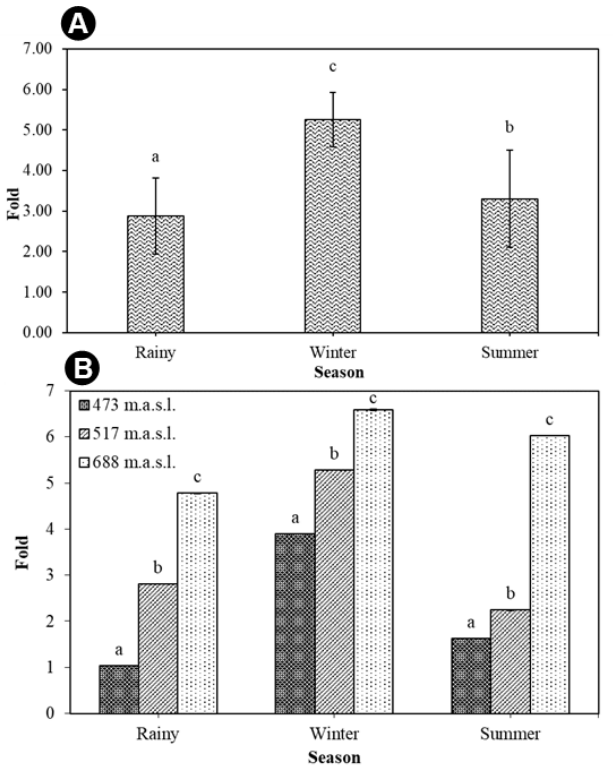
Figure 12 ( A ) Mean of comparisons of total carotenoid content and total chlorophyll ( a and b ) ratios and ( B ) total carotenoid content and total chlorophyll ( a and b ) ratios in each sampling point in each season of T. rigidula collected from electricity posts. Data are the mean values of three replications, and the SE is indicated by vertical bars. The different letters above the columns indicate significant differences ( p ≤ 0.05, n = 9) at each time by Duncan’s new multiple range